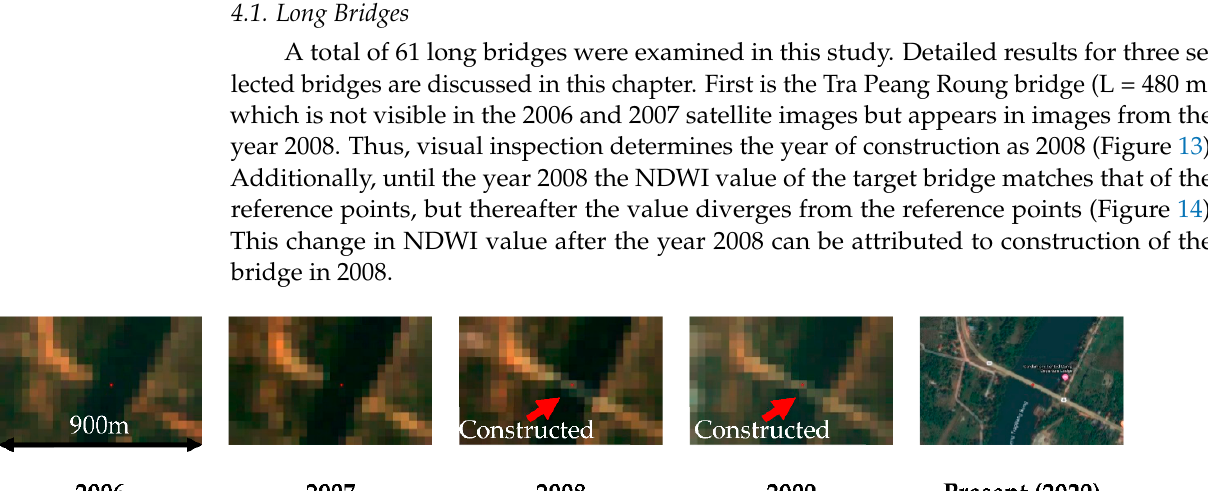
Figure 12. A histogram of the length of bridges in each category.